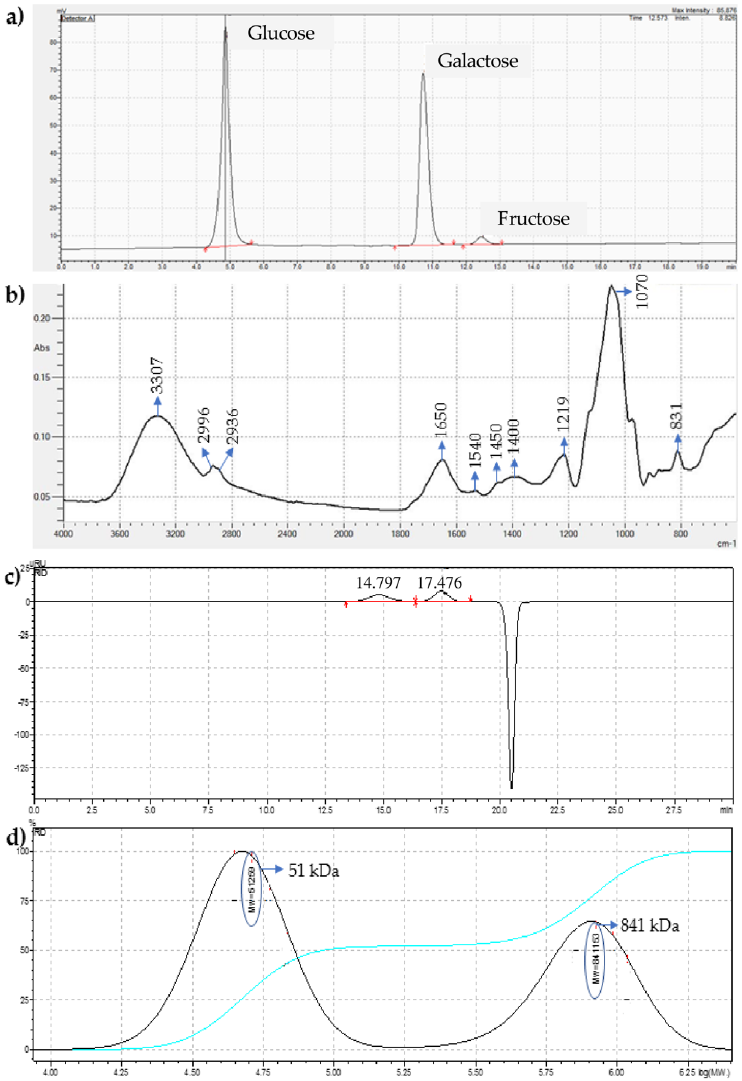
Figure 1. ( a ) Hydrolyzed exopolysaccharides (EPSs) from L. plantarum EIR/IF-1, ( b ) FTIR spectrum of EPSs, ( c ) Gel permeation chromatogram of EPSs, ( d ) molar mass distribution (MMD) pattern. Molecular weight of two fractions in EPSs are indicated in blue